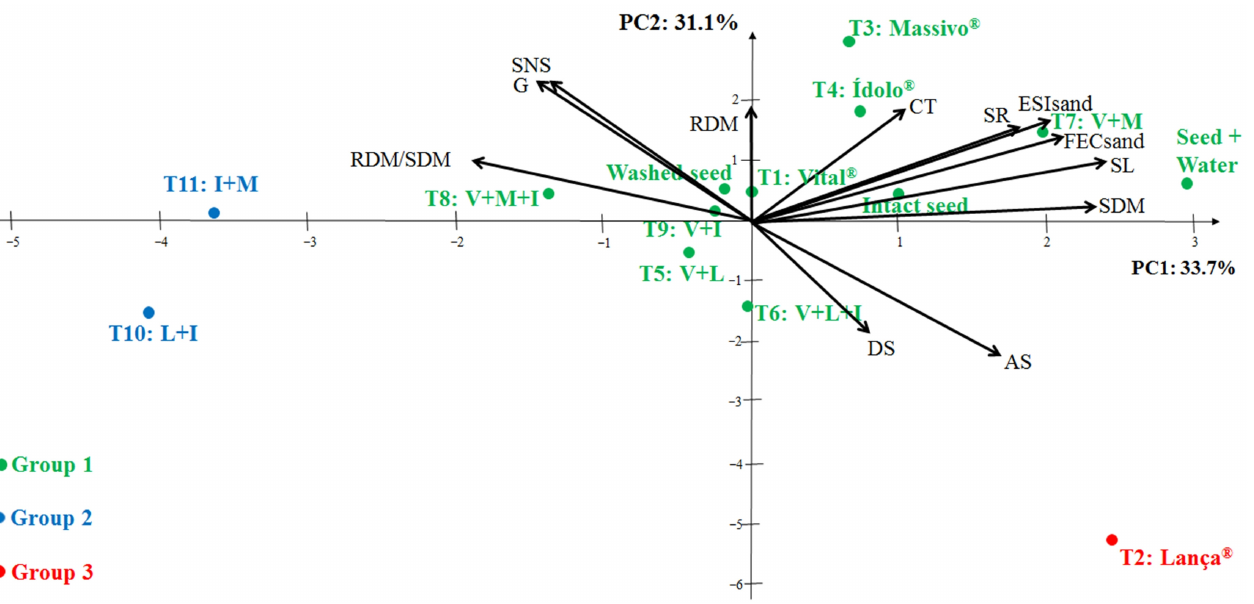
Figure 4. Biplot with the circle of eigenvectors obtained by the analysis of two principal components (PC1 and PC2) established according to germination (G), strong normal seedling (SNS), abnormal seedlings (AS), dead seeds (DS), first emergence count (FECsand), seedling emergence speed index in sand (ESIsand), shoot length (SL), shoot dry matter (SDM), root length (SR), root dry matter (RDM), root-to-shoot dry matter ratio (RDM/SDM), and cold test (CT) of corn MG744 PWU from different seed treatments. Jataí, GO, Brazil, 2022.